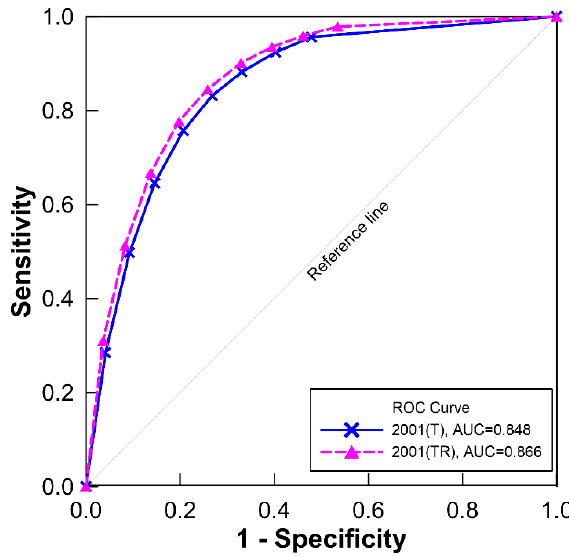
Figure 8. ROC curves of flood vulnerability and inundation traces. Figure 7. ROC curves of flood vulnerability and inundation traces. Through ROC analysis, it was found that the AUC of flood vulnerability considering only topographic factors and that including rainfall were 0.848 and 0.866, respectively, and both were evaluated as “very good” as shown in Table 4. Further, the precision was calculated to confirm the rate at which flood occurrence was detected for the flood vulnerability, which was classified into five classes. This can be obtained by using the number of samples classified as positive in a 2 × 2 confusion matrix as shown in Equation (16), and the range is [0, 1] (perfect value is 1) [49,50]. The precision for each class